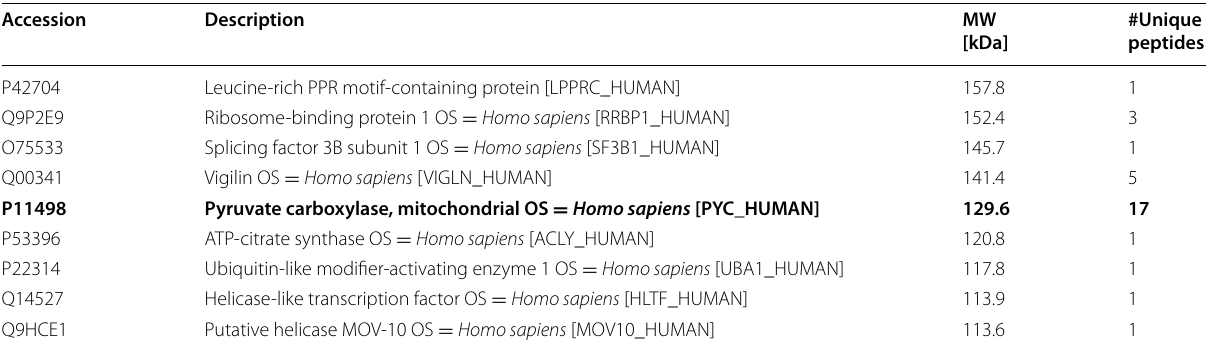
Table 1 List of the main proteins in specific bands with RP11-241J12.3 RNA-binding domains identified by LC-MS